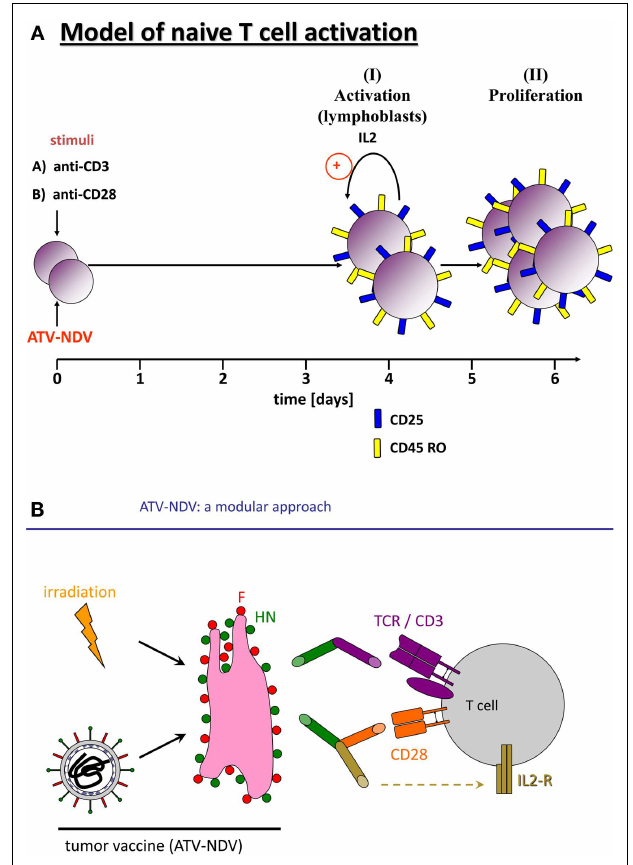
FIGURE 1 |Activation of naïve humanT-cells by co-incubation with NDV infected irradiated tumor cells modified with bi-specific or tri-specific antibodies . (A) Time course of the induction ofT-cell activation and proliferation by a stimulatory cell (NDV infected and y-irradiated tumor cells) optimized for co-stimulation by attachment of the bi-specific fusion proteins anti-CD3 (anti-HNxanti-CD3) and anti-CD28 (anti-HNxantiCD28). Purified and CFSE-labeled naïve humanT-cells were cocultivated for 5 or 7days with the stimulatory cells.The CFSE signal intensities were compared with unstimulated cells by FACS analysis.We also followed by the FACS analysis the expression of the IL-2 receptor α chain (CD25) and of the memory marker CD45RO. (B) Diagram of the components of a tumor vaccine infected by NDV and modified by a bi-specific antibody (anti-HNxanti-CD3, suboptimal amount for signal 1) and a tri-specific immunocytokine (anti-HNxIL-2xanti-CD28, for delivery of twoT-cell co-stimulatory signals via CD28 and